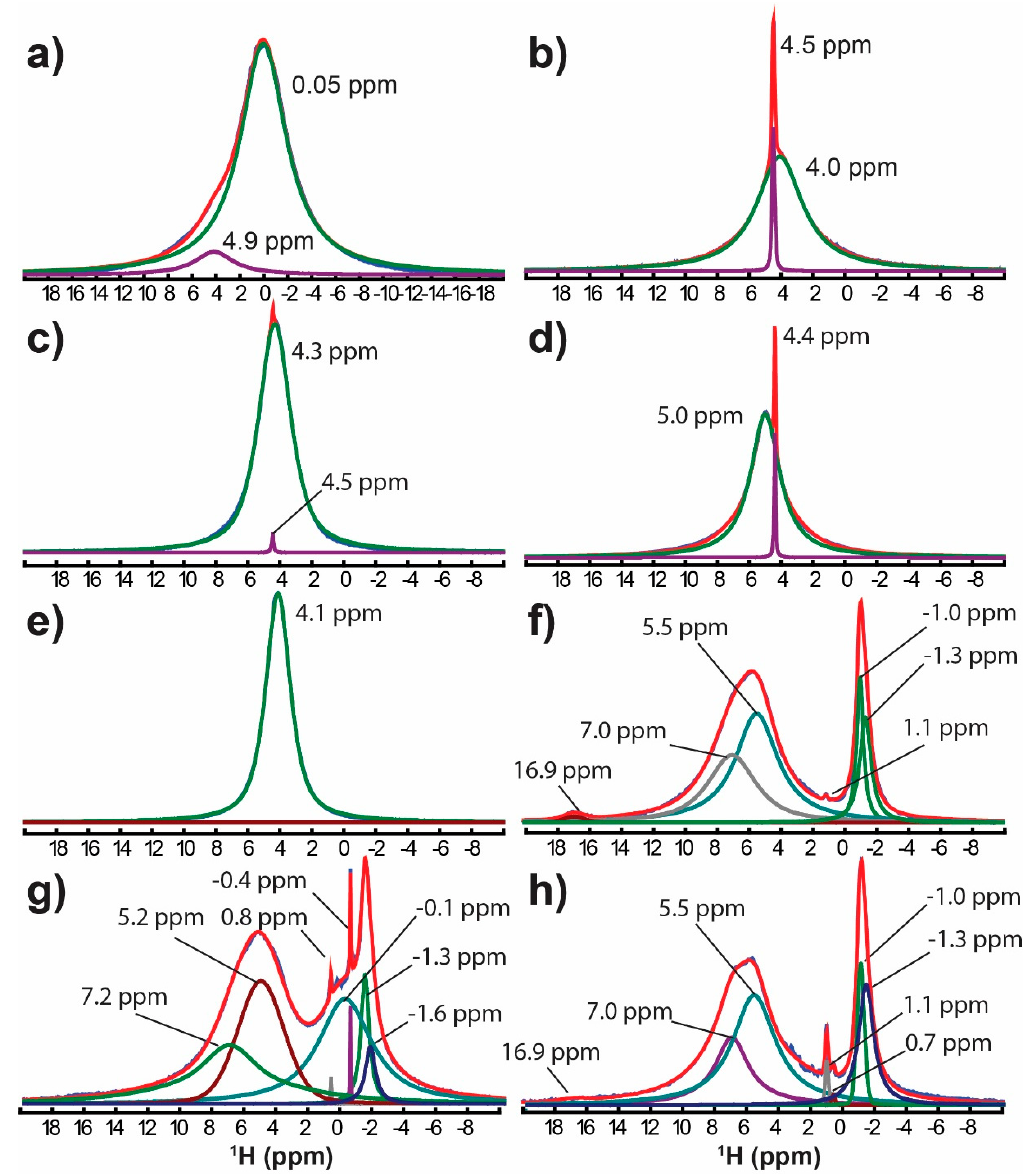
Figure 1. Deconvolution of the 1 H- magic angle spinning (MAS) nuclear magnetic resonance (NMR) spectra for ( a ) brucite, Mg(OH) 2 , ( b ) nitromagnesite, Mg(NO 3 ) 2 · 6H 2 O, ( c ) bischofite, MgCl 2 · 6H 2 O, ( d ) epsomite, MgSO 4 · 7H 2 O, ( e ) magnesium bromide, MgBr 2 · 6H 2 O, ( f ) hydromagnesite, 4MgCO 3 · Mg(OH) 2 · 4H 2 O, ( g ) artinite, MgCO 3 · Mg(OH) 2 · 3H 2 O, and ( h ) dypingite, 4MgCO 3 · Mg(OH) 2 · 5H 2